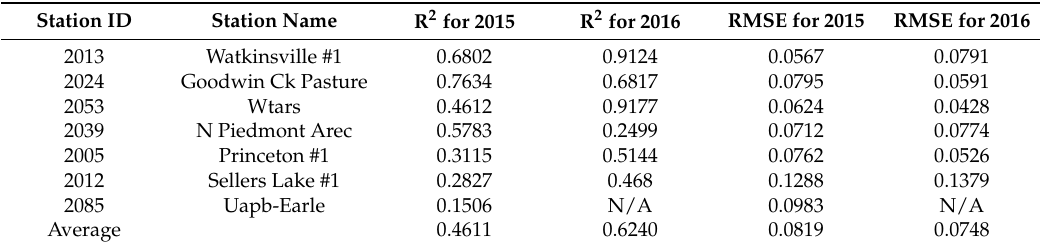
Table 3. Soil Moisture Active Passive (SMAP) validation with SCAN stations.